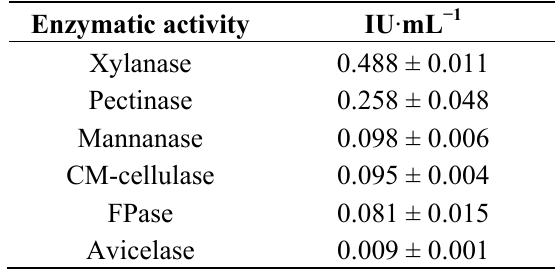
Table 1. Enzymatic activities of the filtered culture supernatant (FCS) from Aspergillus oryzae grown on pretreated dirty cotton residue (PDCR) for 6 days at 28